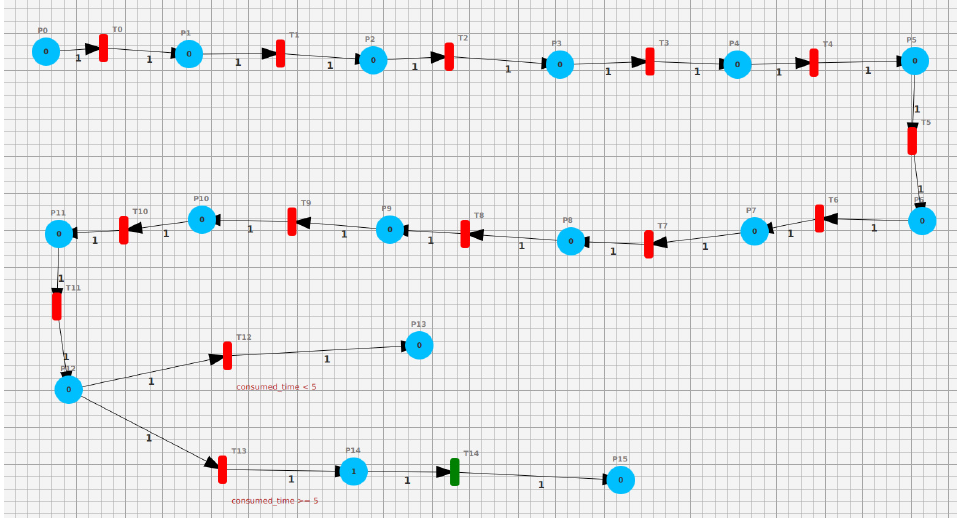
Figure 14. Case study—monitoring of SLA violations. Table 4. Statements and guards of the case study